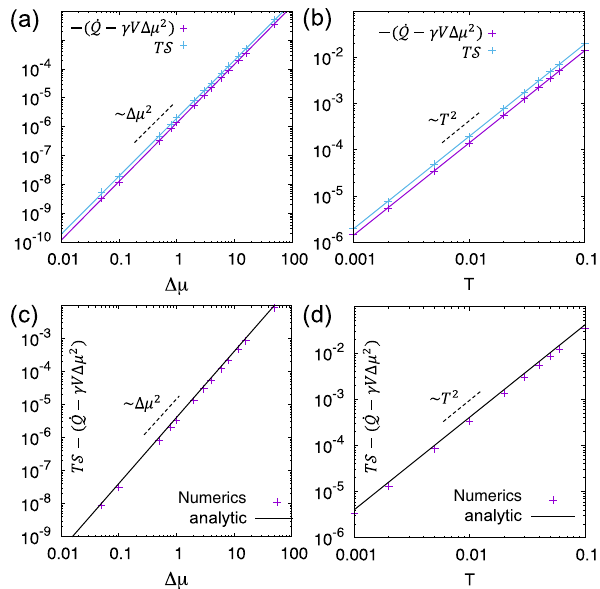
FIG. 2. In the absence of phase separation, namely, for a homogeneous average profile of density [ h ϕ ð x Þi ¼ cst], the _ Q − γ V Δ μ 2 nontrivial contribution to heat rate and the density field irreversibility T S scale like T 2 at small temperature T and as Δ μ 2 at small driving parameter Δ μ , as shown, respectively, in (a) and (b), where solid lines are guide lines. Their difference also exhibits similar scalings in these regimes, as shown in (c),(d), and it is in good agreement with our prediction (C13) reported in black solid lines. Simulation details are in Appendix D. Param- ¯ ϕ eters: − a ¼ b ¼ 0 . 25 , κ ¼ 4 , ¼ 1 , V ¼ 128 , (a),(c) T ¼ 10 − 3 , and (b),(d) Δ μ ¼ 1